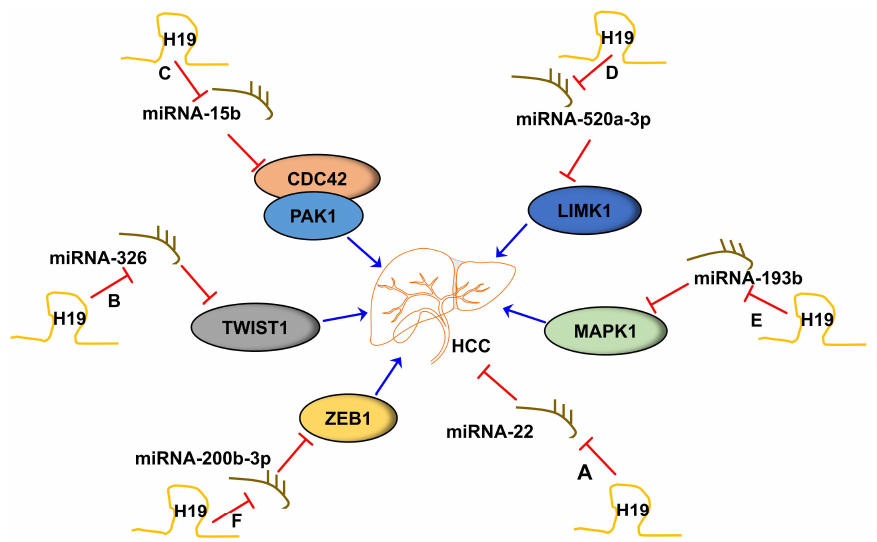
Figure 2. LncRNA H19 functions as miRNA sponges in HCC. ( A ) LncRNA H19 sponged miRNA- 22, promoting the development of HCC. ( B ) LncRNA H19 sponged miR-326, thus increasing the expression of TWIST1, eventually promoting the development of HCC. ( C ) LncRNA H19 sponged